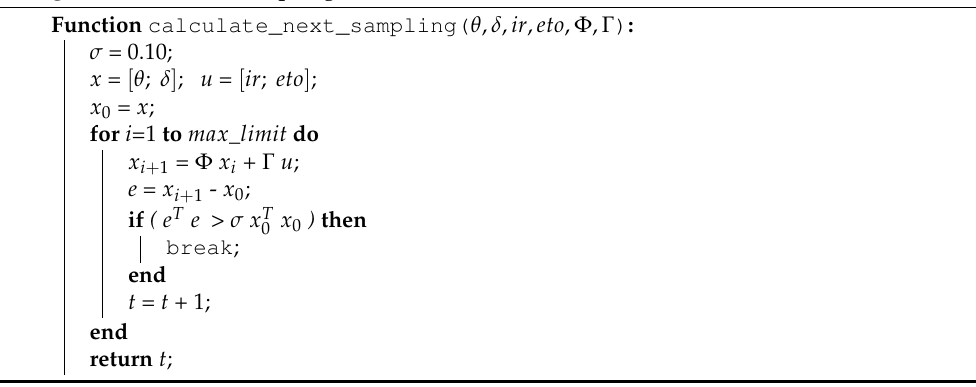
Algorithm 2: Next sampling estimation based on error measurements.